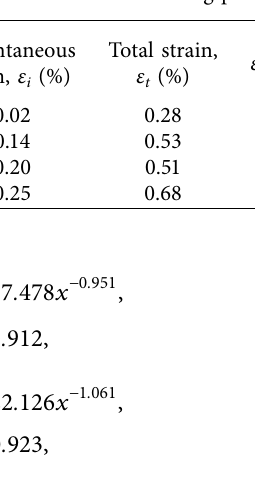
Table 4: The physical parameters of rock-concrete composite specimens and creep test results under different confining pressures.